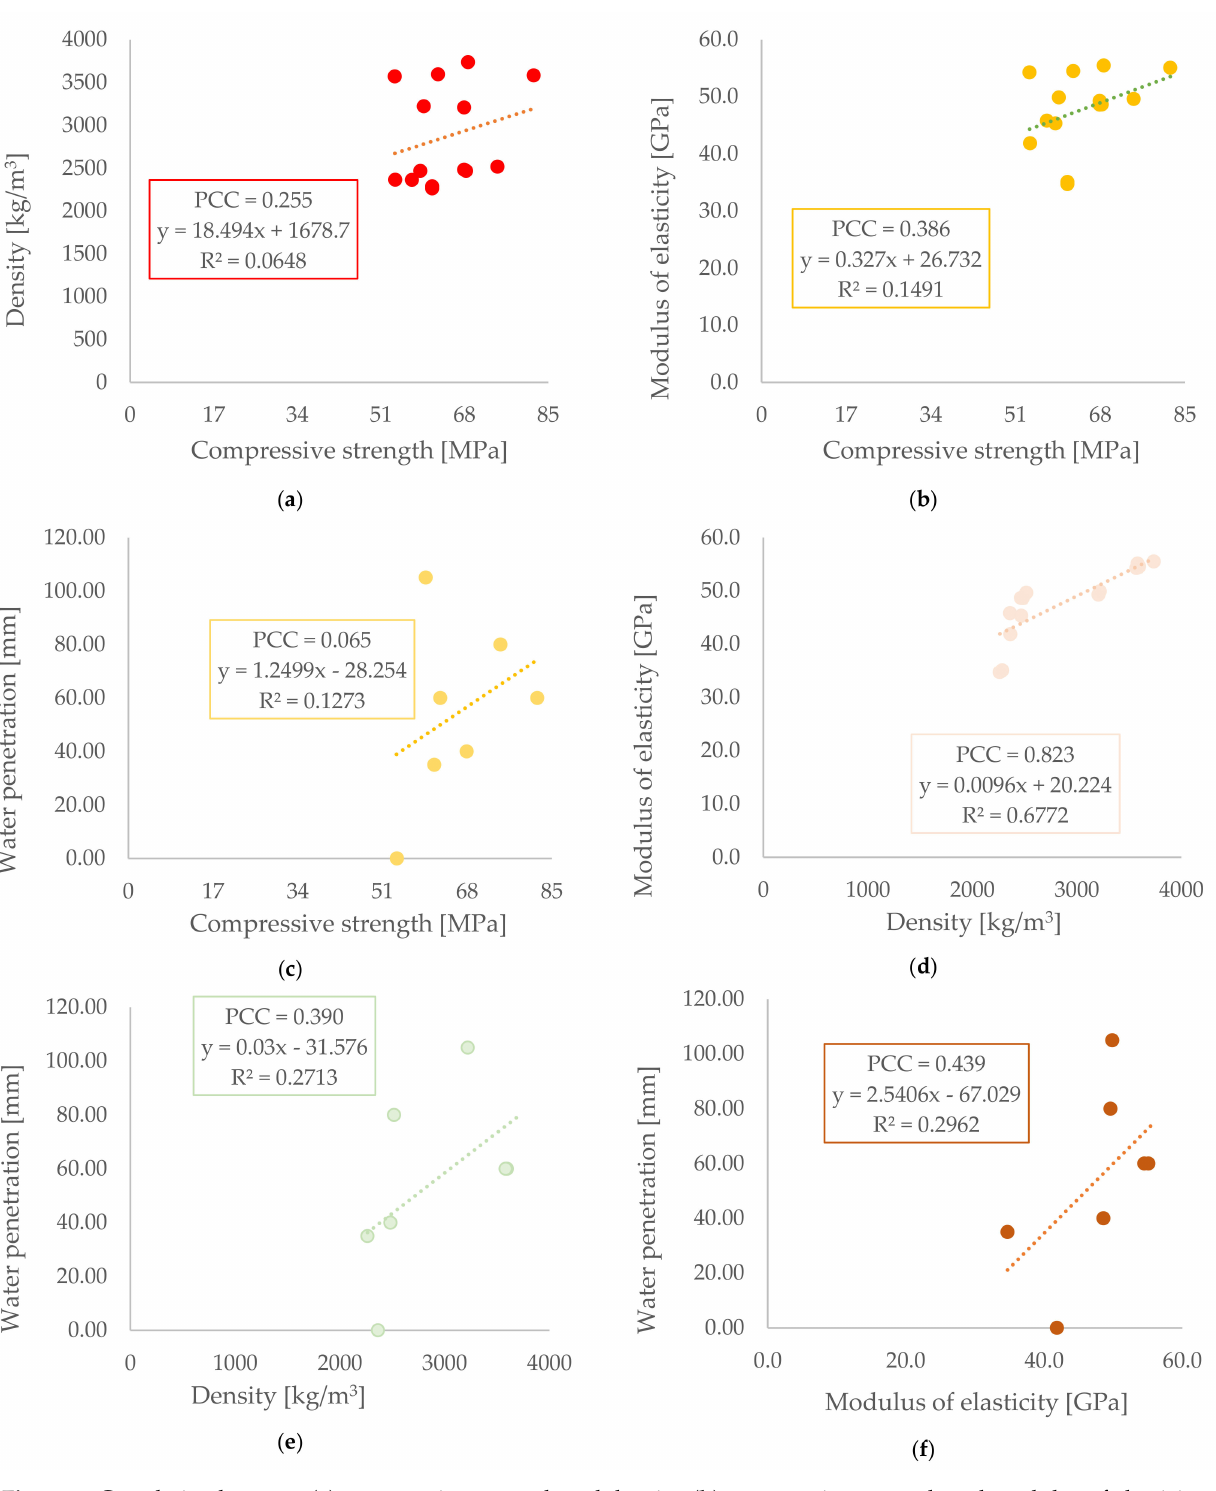
Figure 8. Correlation between ( a ) compressive strength and density, ( b ) compressive strength and modulus of elasticity, ( c ) compressive strength and water penetration, ( d ) density and modulus of elasticity, ( e ) density and water penetration, and ( f ) modulus of elasticity and water